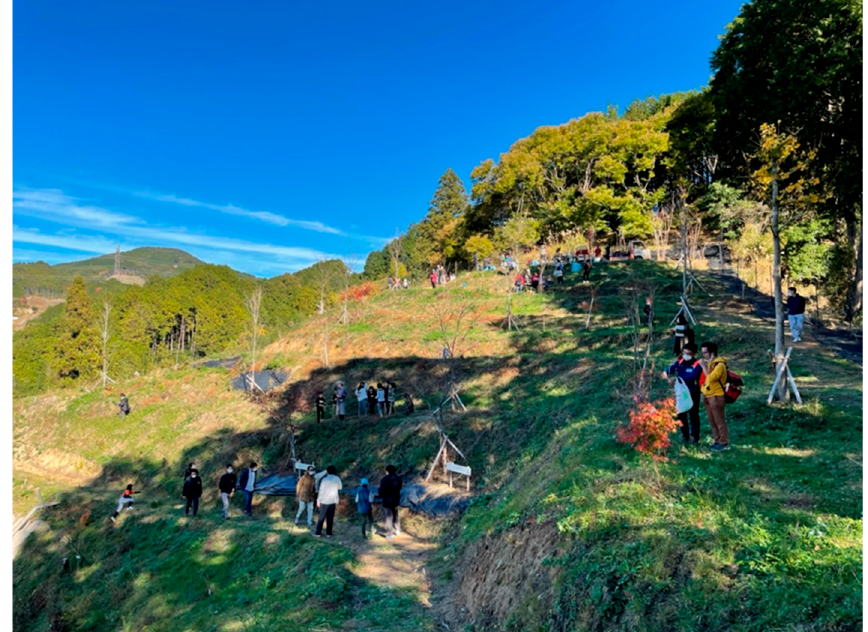
Figure 7. Reconstruction Autumn Foliage Viewing Event (obtained by Yoshio Harada [first author] on 28 November 2021).